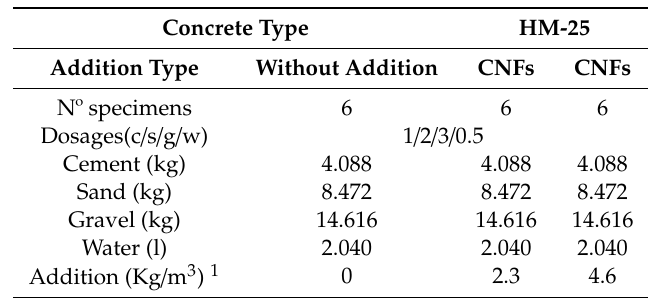
Table 2. Dosage for the mixes and material content depending on the